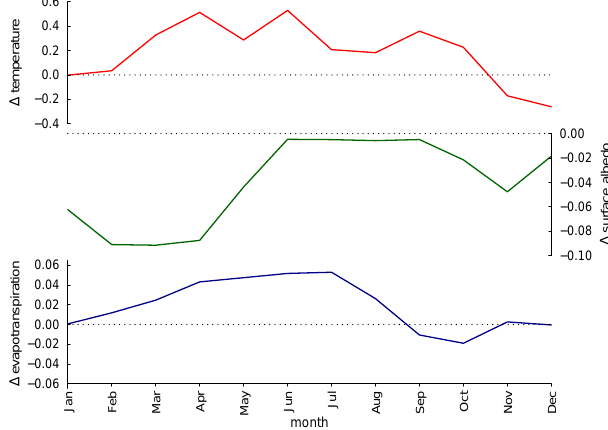
Fig. 9. Differences in the annual cycle of monthly mean temperature in [K] (red line), surface albedo [/] (green line), and evapotranspira- tion in [mmday − 1 ] (blue line) in the northern high latitudes (60 ◦ N to 80 ◦ N, only land) caused by the biogeophysical effect of vegeta- tion dynamics (DYN – STAT PS) averaged over the period from the year 2070 until